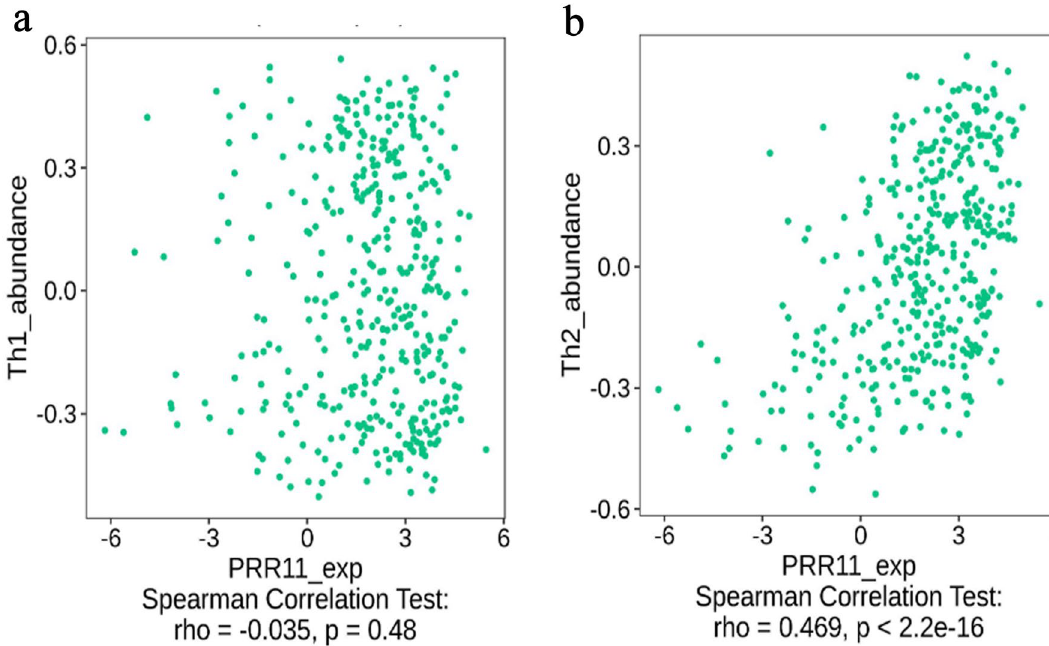
Figure 7. Correlation of PRR11 expression with infiltration level of Th1 and Th2 in BLCA from TISIDB